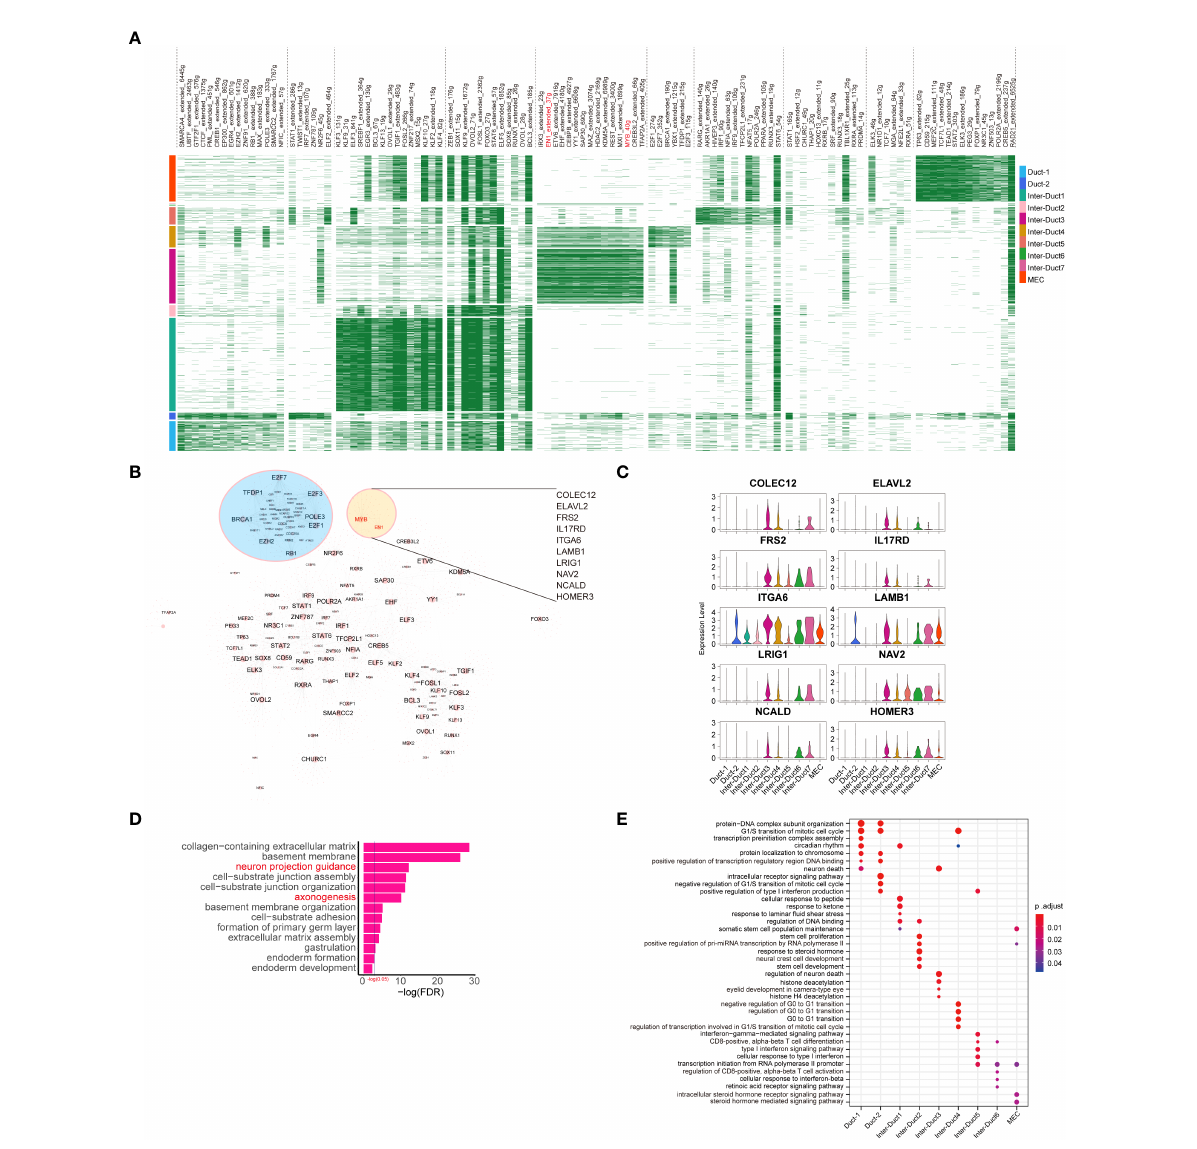
FIGURE 3 Development of epithelial cell subtypes is driven by distinct TFs. (A) Heatmap showing differentially expressed transcriptional regulons in different epithelial cell subtypes. (B) Epithelial cell transcription factor regulatory network, of which signi fi cant clusters or regulons with their targets are labeled. (C) Violin plots showing the relative expression of downstream target genes coregulated by MYB and EN1 in each epithelial cell subtype. (D) The result of GO enrichment analysis for target genes coregulated by MYB and EN1 and genes interacting with them. Biological processes terms associated with the peripheral nervous system are highlighted in red font. (E) Dot plot showing the results of GO enrichment analysis for predominant TFs of different epithelial cell